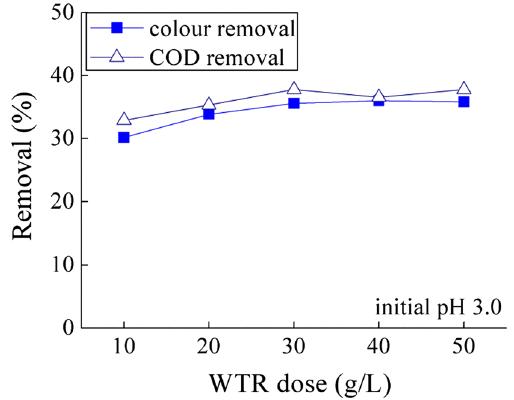
Fig. 4 Effect of dose of WTR on colour removal during coagulation Fig. 5 Effect of WTR dose on colour and COD removal for wastewa- ter at initial pH 3.0 in sorption